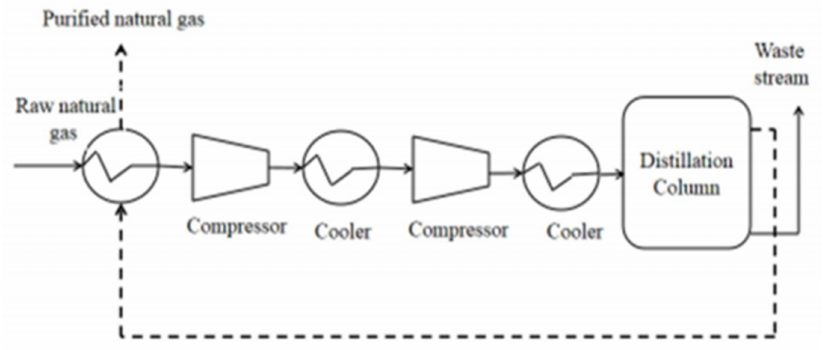
Figure 5. Process flow diagram of cryogenic separation process [23]. Reprinted/adapted with permission from Ref. [23]. Copyright 2022,